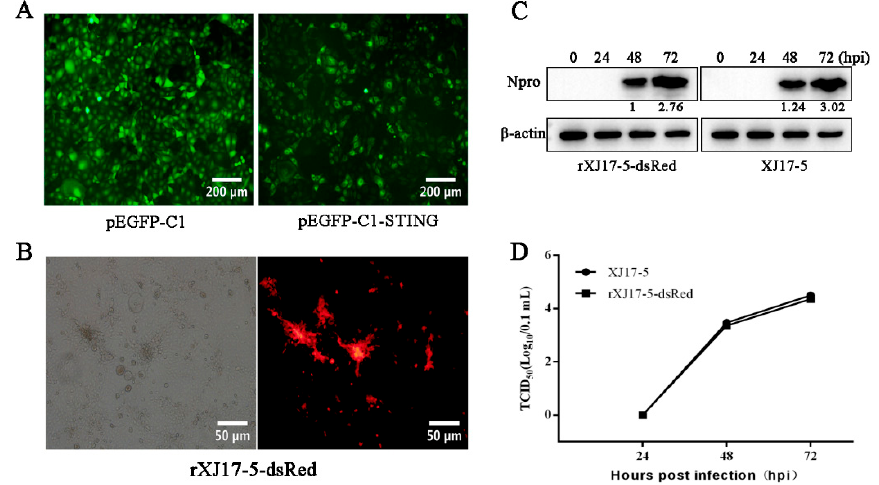
Figure 1. Porcine STING stable Marc-145 cells and characterization of the rescued rXJ17-5-dsRed PRRSV. ( A ) Porcine STING stable Marc-145 cells (right) and vector pEGFP-C1 control stable Marc-145 cells (left) obtained by G418 selection. ( B ) Marc-145 cells were infected with rXJ17-5-dsRed PRRSV at a MOI of 0.1, with cytopathic effect (CPE) and dsRed expression at 48 h post infection (hpi). ( C , D ) The in vitro growth kinetics of the cloned rXJ17-5-dsRed virus and the parental XJ17-5 virus. Marc-145 cells were infected with PRRSV at a MOI of 0.1. The growth curve of both PRRSVs in Marc-145 cells within 72 hpi were determined by Western blotting ( C ) and TCID50 assay ( D ). The values of PRRSV N protein (Npro) quantification by gray scanning were shown below the bands following normalization by β -actin.